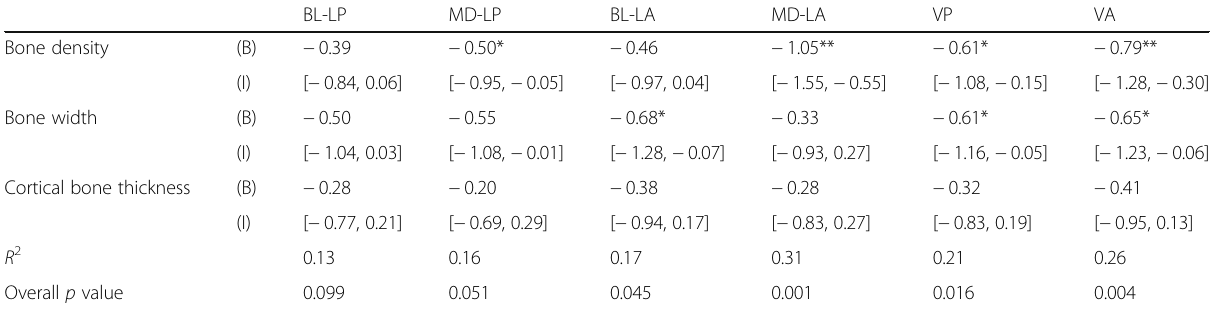
Table 5 Multiple linear regression analysis of the correlation between bone condition and implant placement accuracy parameters